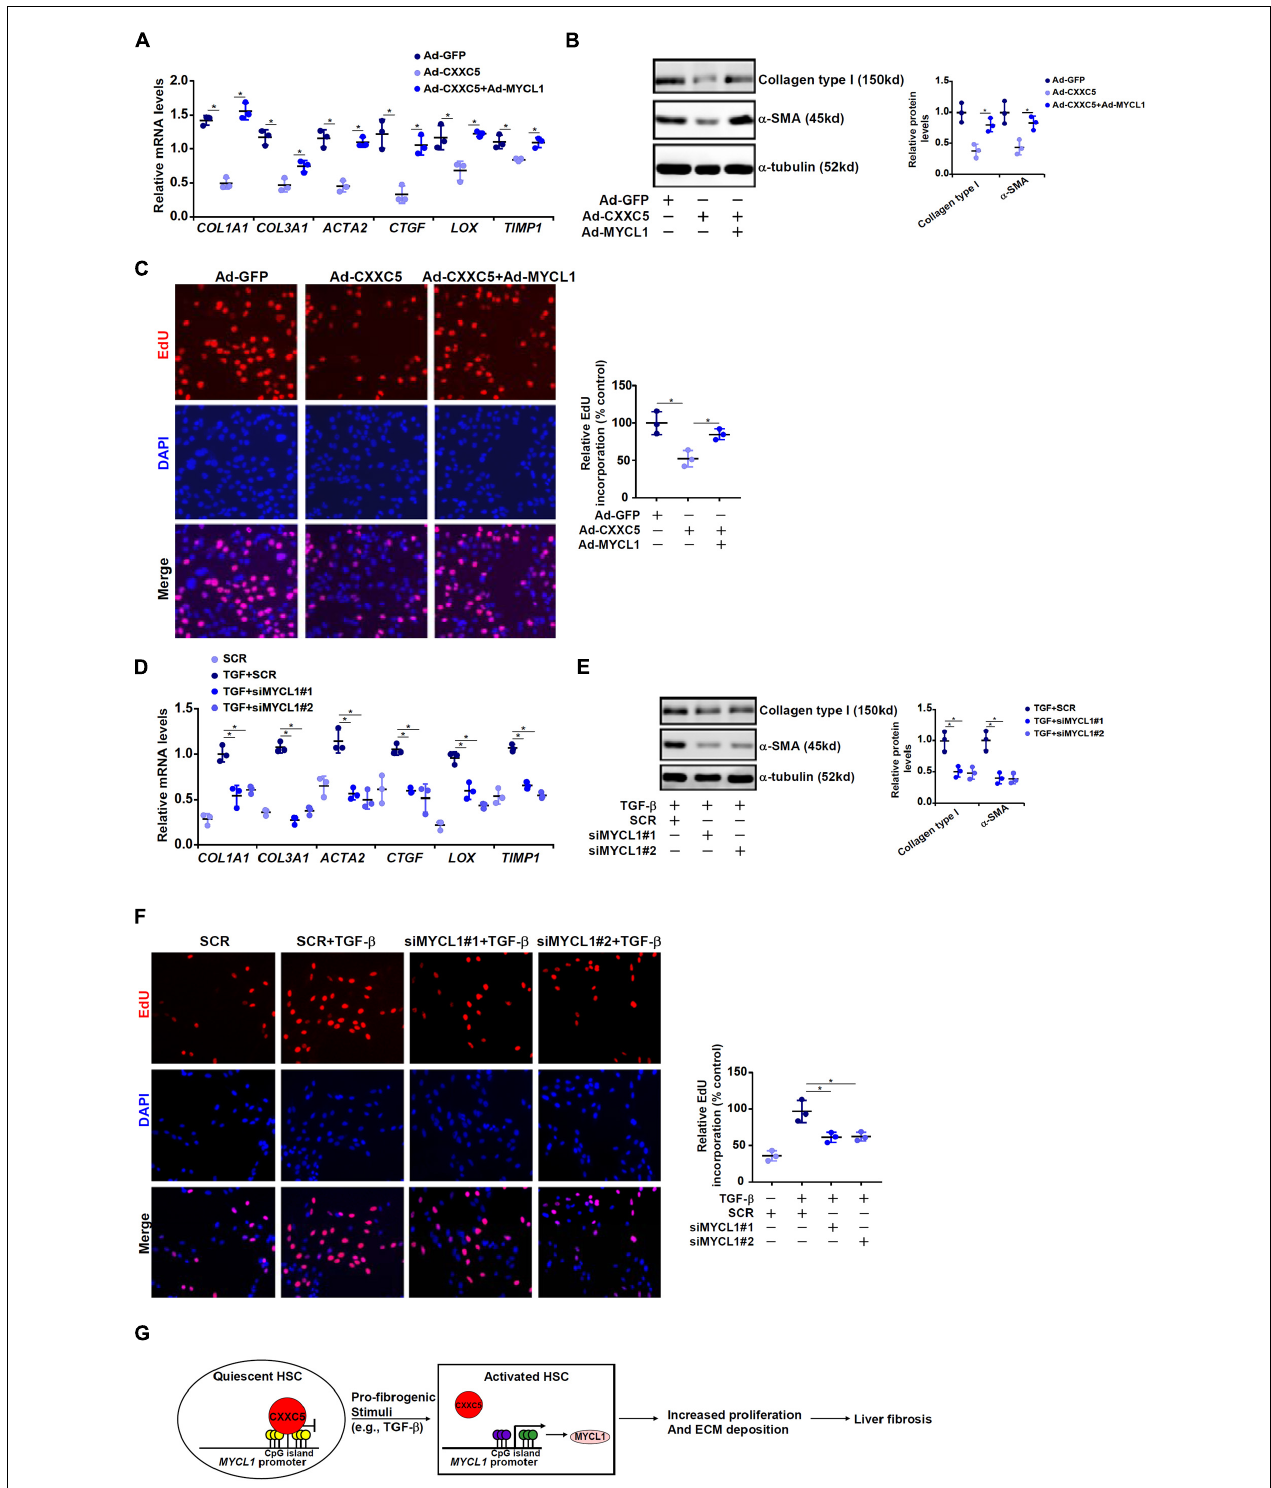
FIGURE 5 | MYCL1 promotes HSC activation. (A–C) LX-2 cells were infected with indicated adenovirus. Gene expression levels were examined by qPCR and Western. Cell proliferation was measured by EdU staining. (D–F) LX-2 were transfected siRNA targeting MYCL1 or scrambled siRNA (SCR) followed by treatment with TGF- β 1 (2 ng/ml). Gene expression levels were examined by qPCR and Western. Cell proliferation was measured by EdU staining. All experiments were repeated three times and one representative experiment is shown. (G) A schematic model. * p < 0.05.